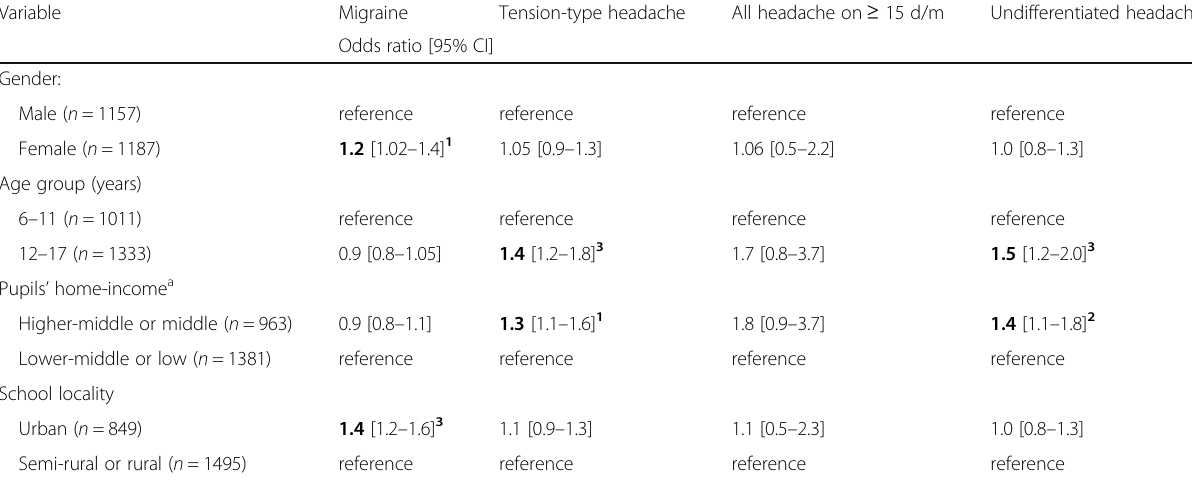
Table 4 Bivariate analyses of associations of headache types with demographic variables ( N = 2344) Variable